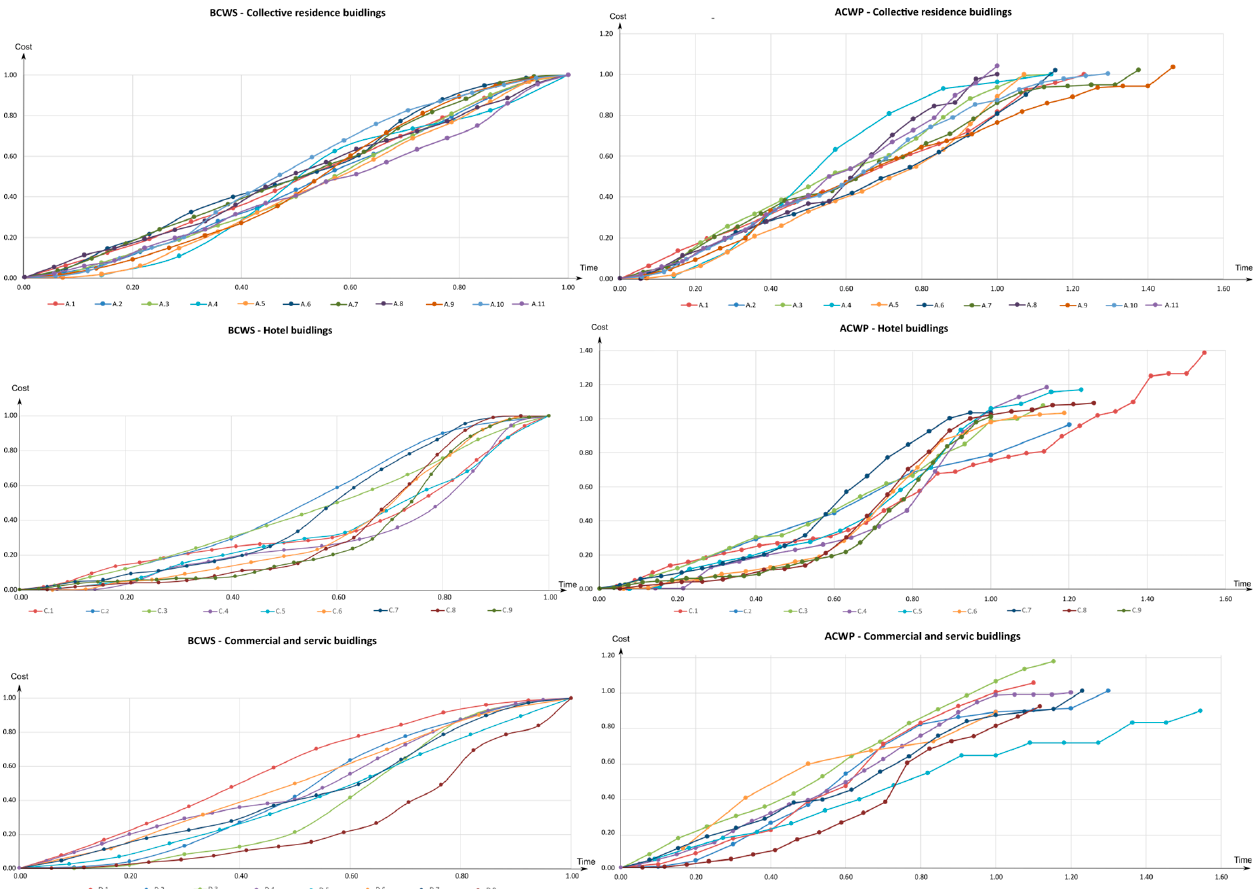
Figure 4. Graph cumulative cost